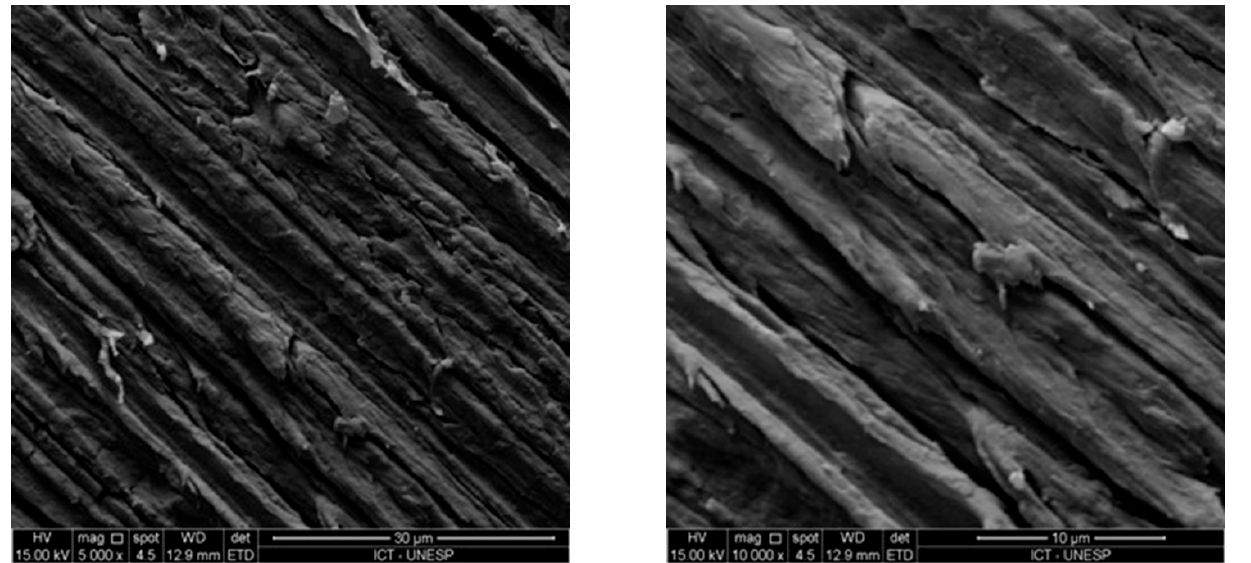
Figure 4. Control group (CTL). No surface treatment: even after the polishing procedure was completed, the grooves created by the milling process remained apparent on the PEEK sample. Magnification: 5000× and 10,000×.